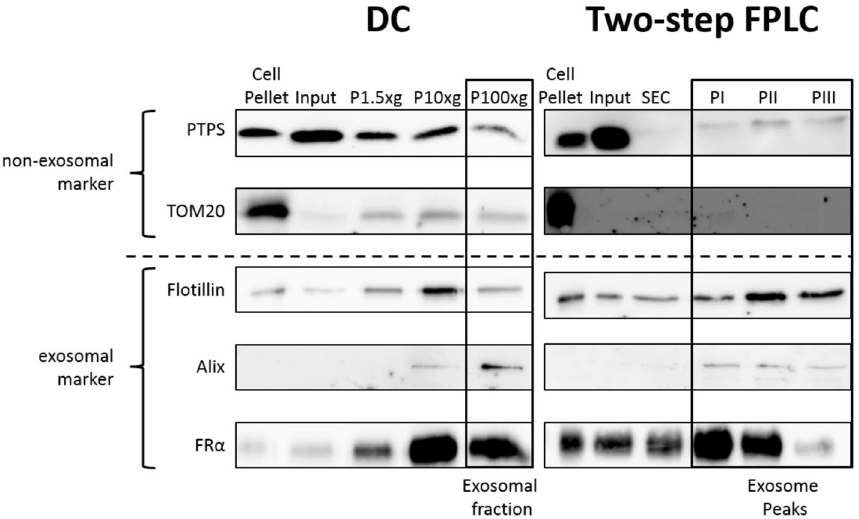
Figure 3. Characterization of EVs obtained by FPLC in comparison to EVs isolated by the DC protocol. EVs were prepared as described for the specific method. One sample from HEK293 cells expressing polyhistidine- tagged FRα was split into two halves to compare the expression of protein markers. For each step and method 1 µg total protein was loaded onto a gel. The blots were probed for EV-enriched proteins like FRα, flotillin and Alix. Additionally, the reduction of intra- and extracellular contaminations was investigated with the proteins TOM20 and the stably expressed PTPS. For this analysis we considered also the intermediate centrifugation steps of the DC protocol. Peak II (PII) of the two-step FPLC combining SEC and IMAC shows the strongest recovery of EV markers and reduction in EV-negative ones.